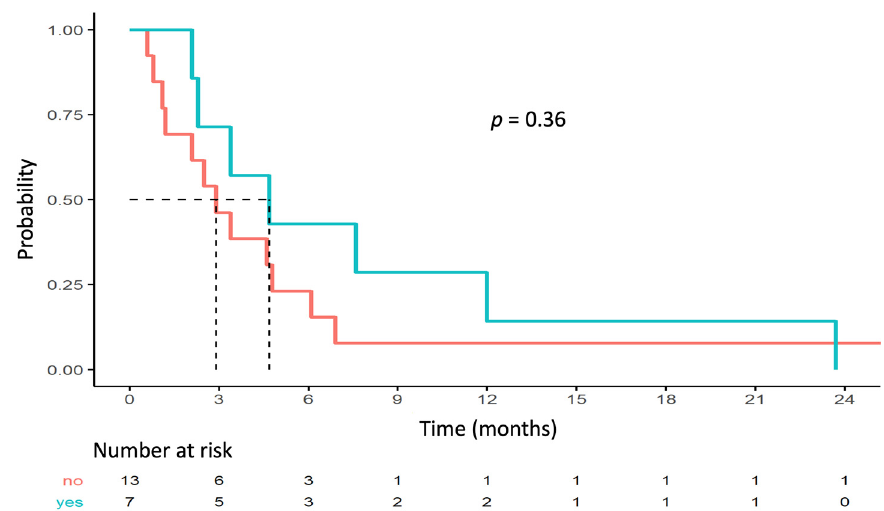
Figure 3. PFS depending on TOP2A/ERBB2 co ‐ amplification status